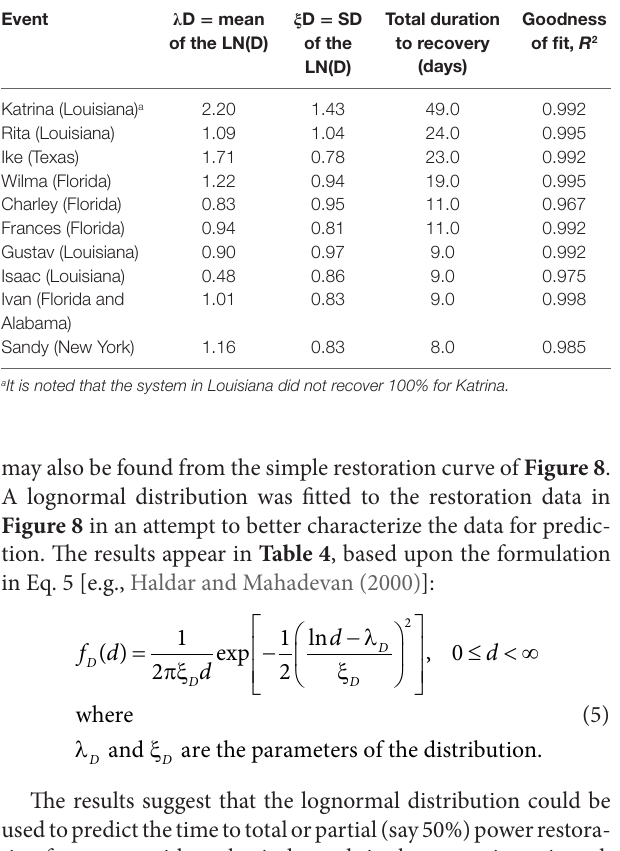
TaBle 4 | Lognormal distribution parameters for “time to recovery”